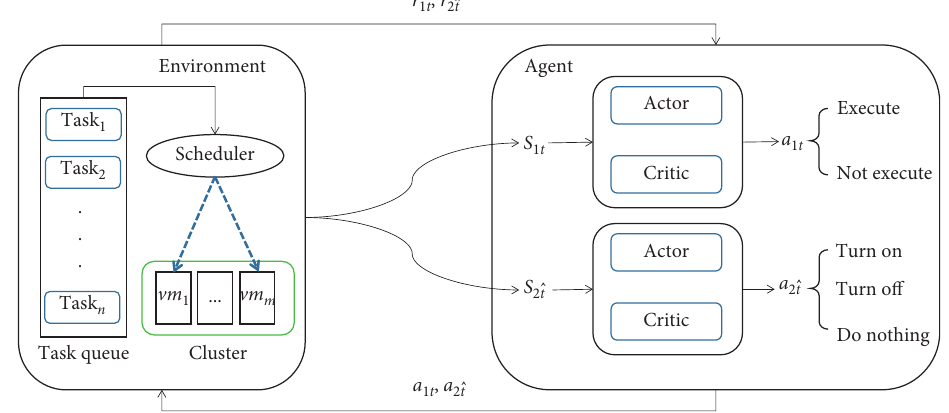
Figure 1: Scheduling system